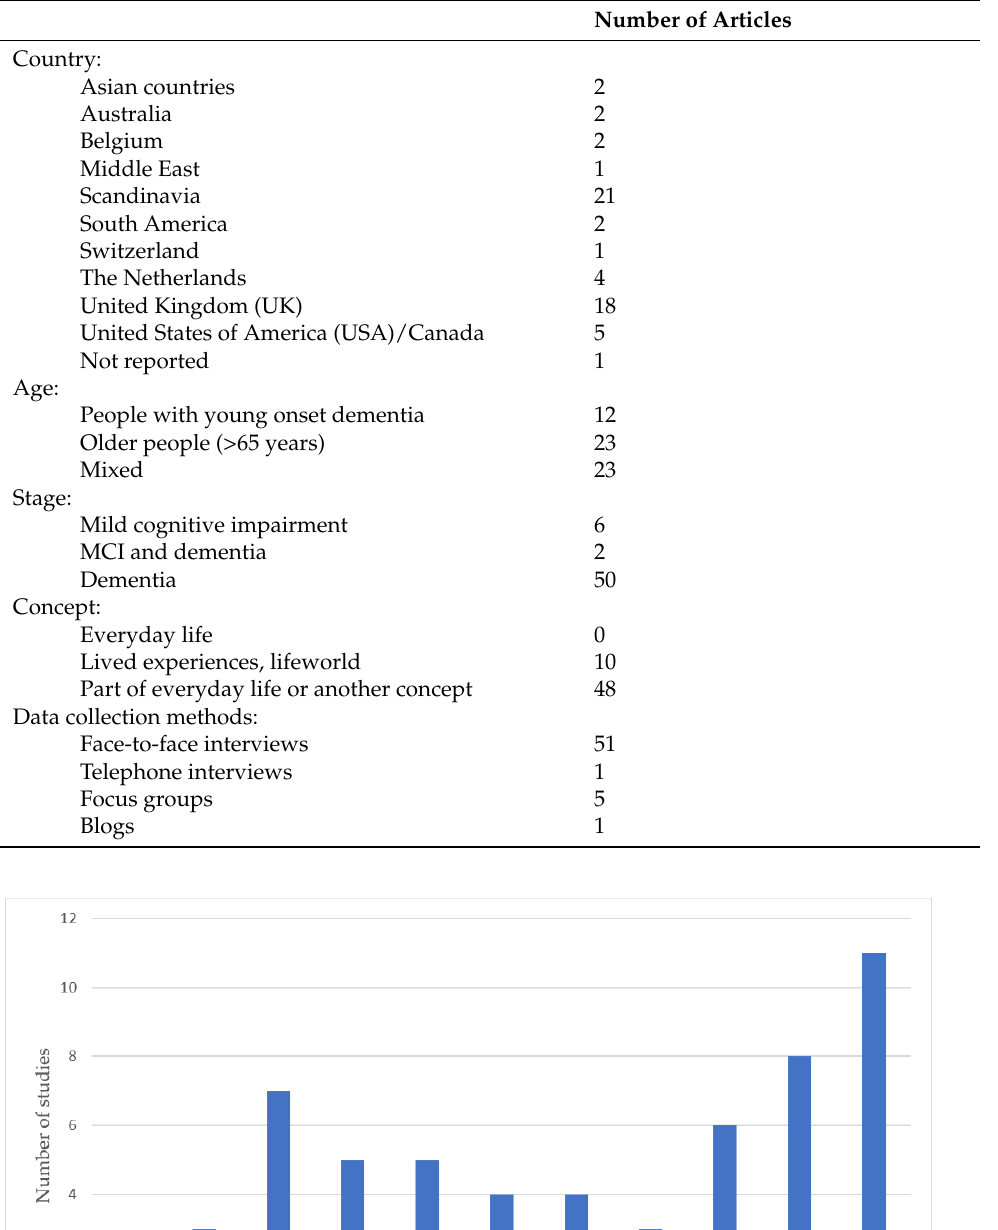
Table 3. Summary of study characteristics.